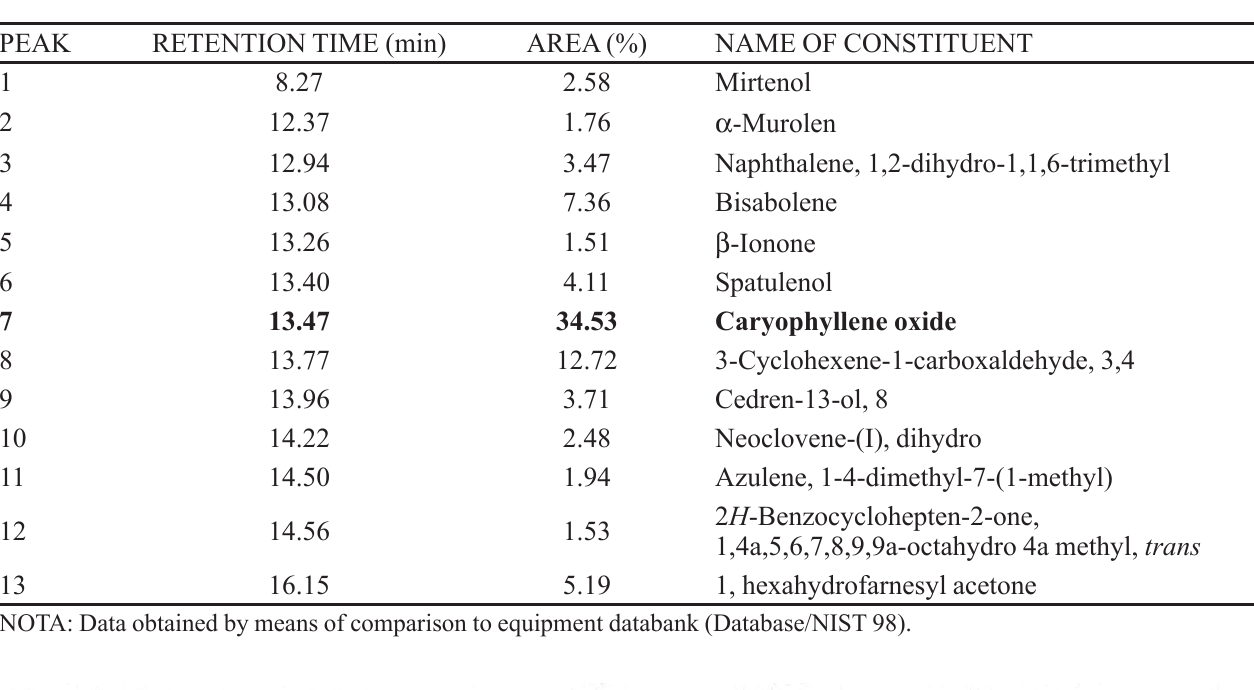
TABLE I - Constituents of essential oil of A. lanceolatus